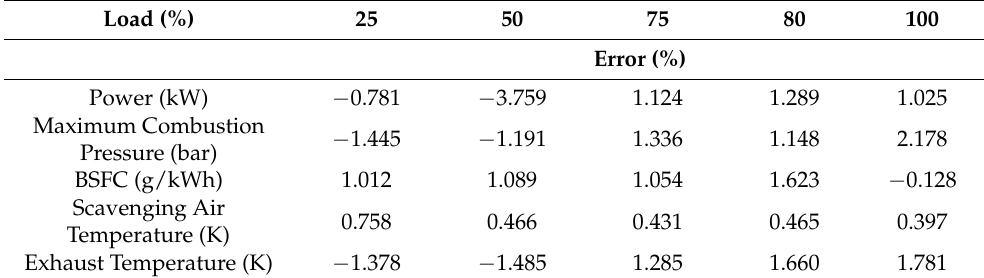
Table 5. Calculation errors of parameters in gas mode.